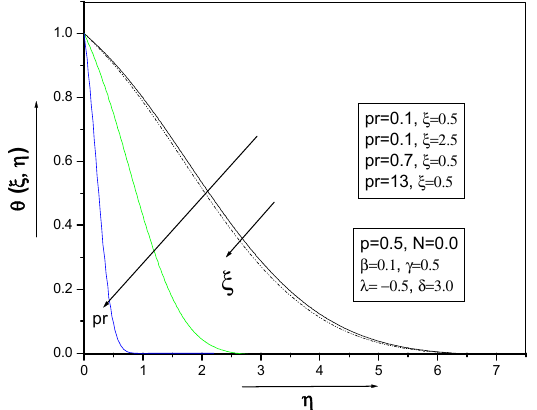
Figure 12. Effect of the Prandtl number on temperature profile.